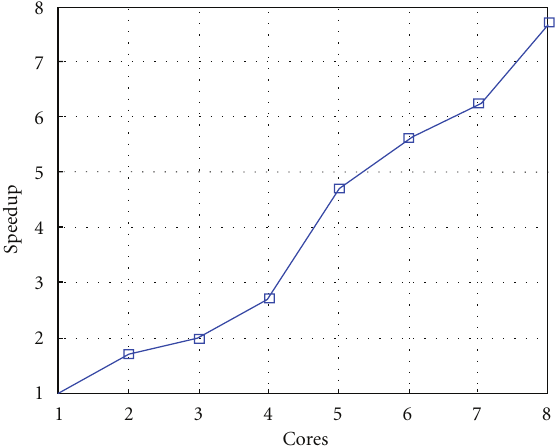
Figure 19: Test 1: Algorithm I: Speedup. Δ τ I = 0 . 04.